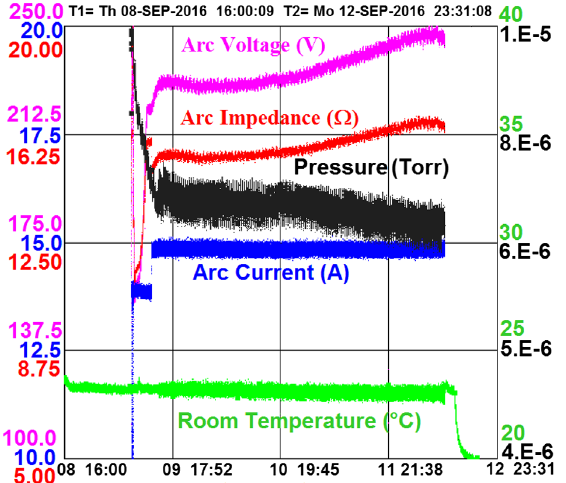
FIG. 12. Prototype of current-regulated arc modulator chassis showing the 700 V transformer, dc power supplies, high-voltage card, trigger/feedback card and the MOSFET.